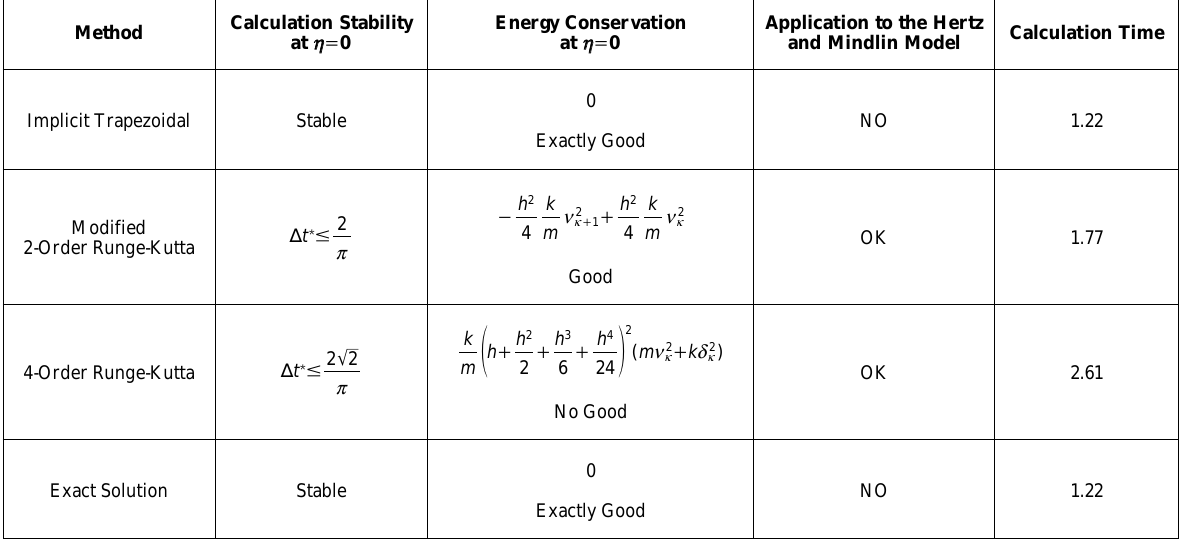
Table 3 Comparison of 4 methods of calculating the estimated value of force ( k (cid:2) t / ∆ t , h (cid:2) ∆ t